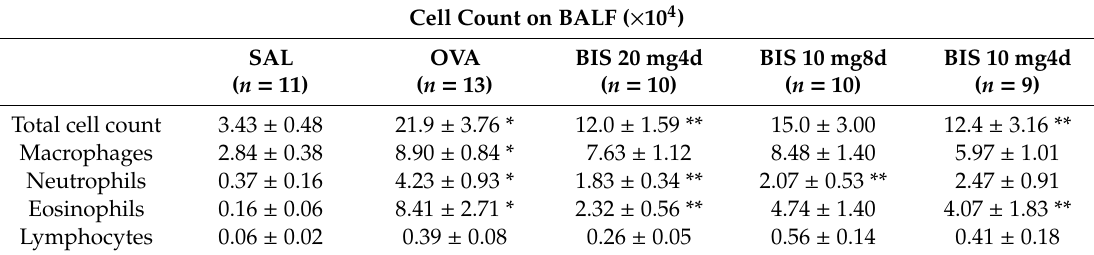
Table 2. E ff ects of biseugenol on bronchoalveolar lavage fluid (BALF)